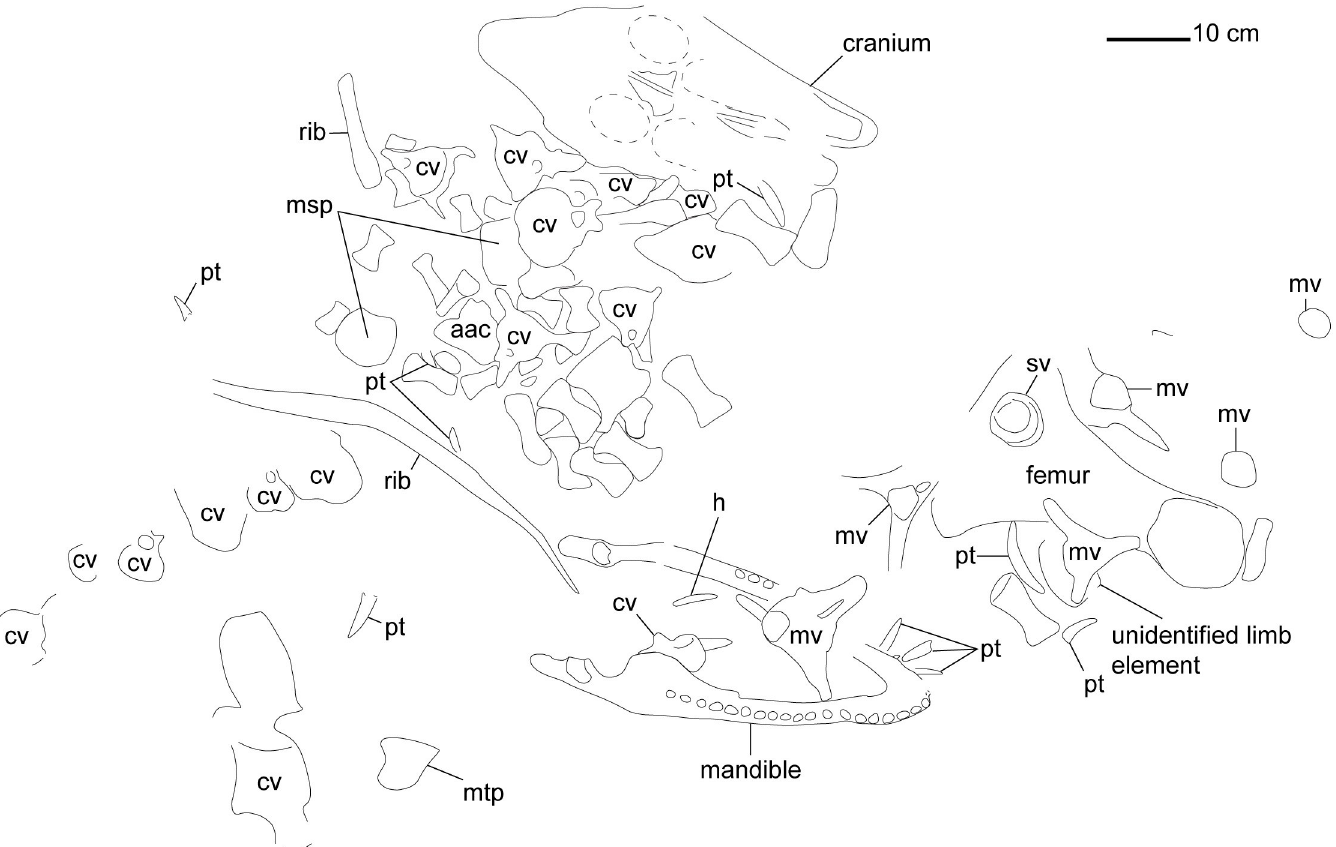
Fig 2. Excavation map of Cardiocorax mukulu (MGUAN PA278). Abbreviations: aac ., atlas-axis complex; cv ., cervical vertebra; h ., hyoid bone; msp ., mesopodial; mtp ., metapodial; mv ., mosasaur vertebra; pt ., plesiosaur tooth; sv ., shark vertebra. The spatial relationships and scaling of the elements are approximate.